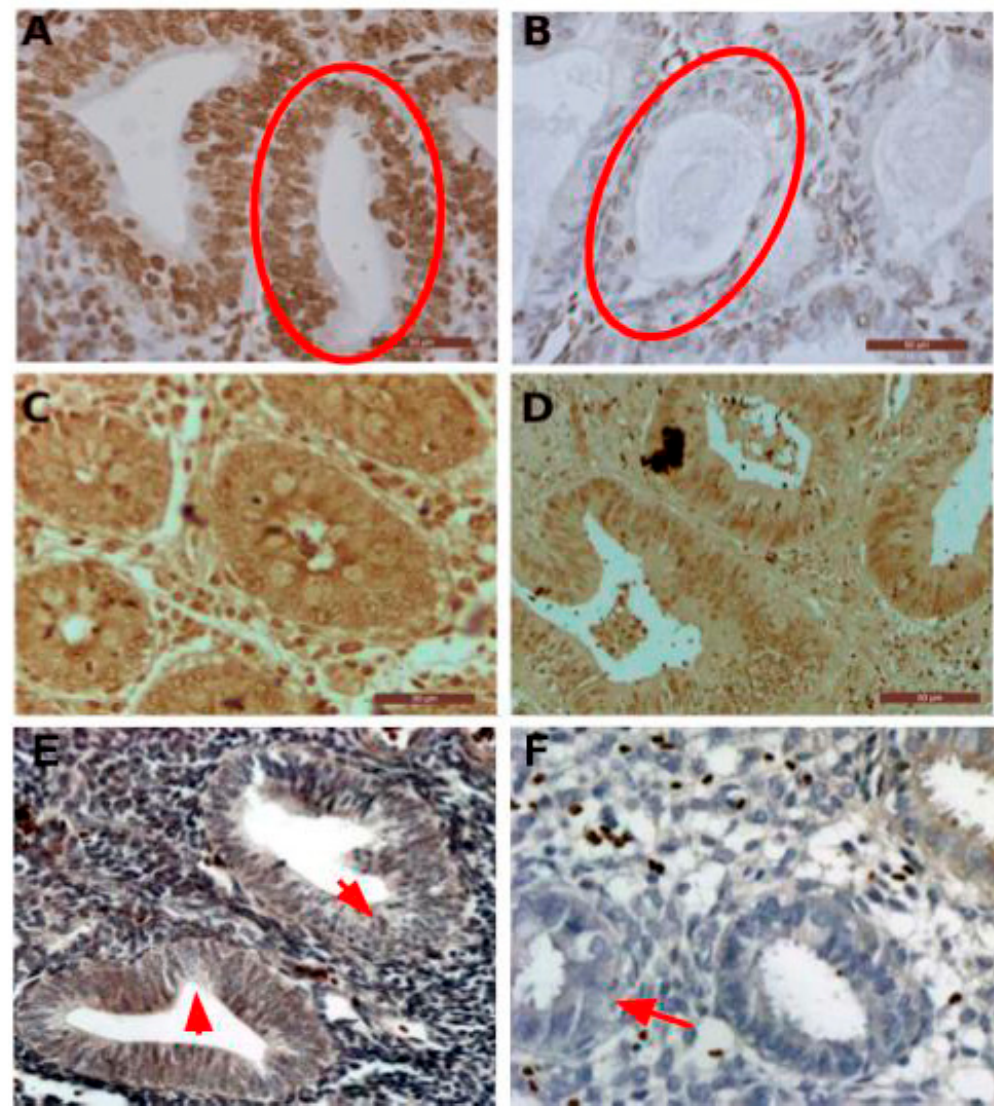
Figure 4. The PTENz7-70 dual aptamer specifically detects PTEN protein in normal and neoplasic endometrial and colon samples. ( A ) Human non-neoplasic endometrial tissue treated for antigen retrieval and stained using the reduced PTENz7-70 dual aptamer. Nuclei were counterstained with hematoxylin stain. The circle indicates PTEN + acinar cells. ( B ) Human hyperplasic tissue stained using the reduced PTENz7-70 dual aptamer counterstained with hematoxylin. The circle indicates PTEN − acinar cells ( C ) Normal human colon tissue treated with PTENz7-70 dual aptamer. Counterstain was omitted. ( D ) Human colon adenocarcinoma stained with PTENz7-70 dual aptamer. ( E , F ) The arrows in the figures show examples of areas in hyperplasic tissue with partial loss of PTEN (classified as PTEN +/ − ) signal in acini. Scale bars represent 50 µ